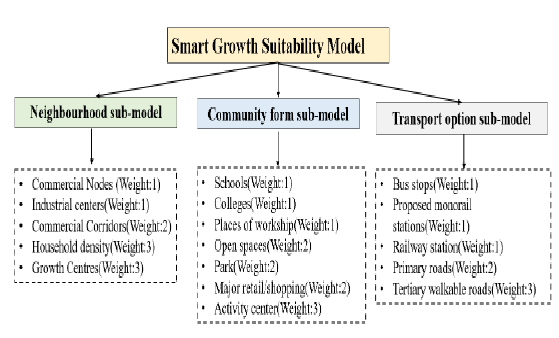
Figure 3 : Smart growth suitability sub-models with feature classes